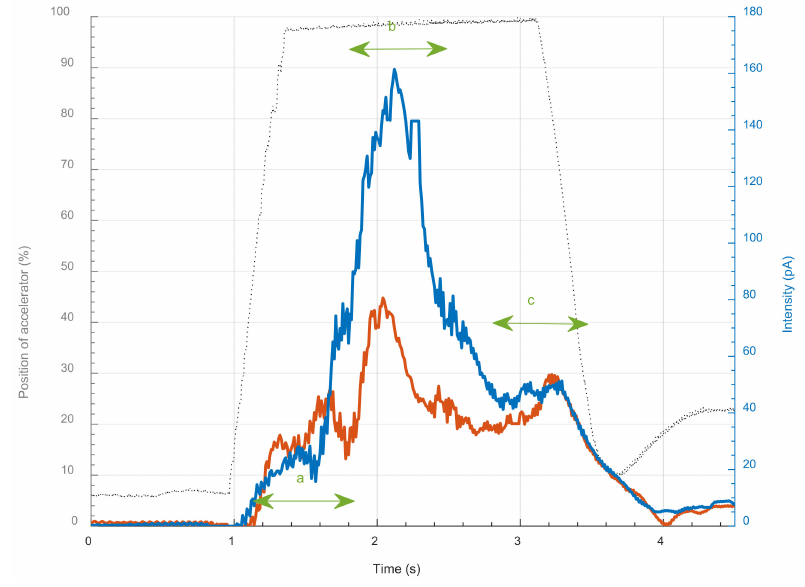
Figure 10. Evolution of particle emissions during a transient for cases 1 and 2. The average representative curve of particle emissions of the 100 transients for case 2 has the same shape as in case 1, but with a much lower peak in the second zone (b). The average current measured for 100 transients for case 1 and case 2 are shown in Table 3